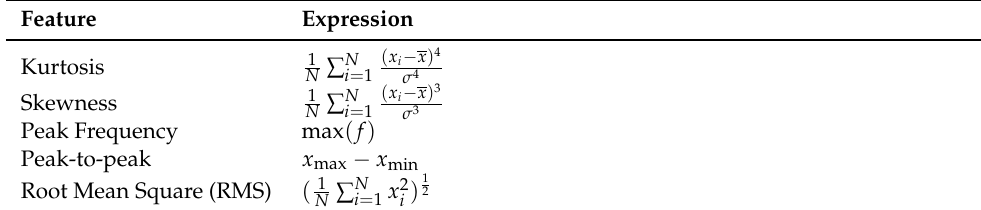
Table 1. Statistic feature